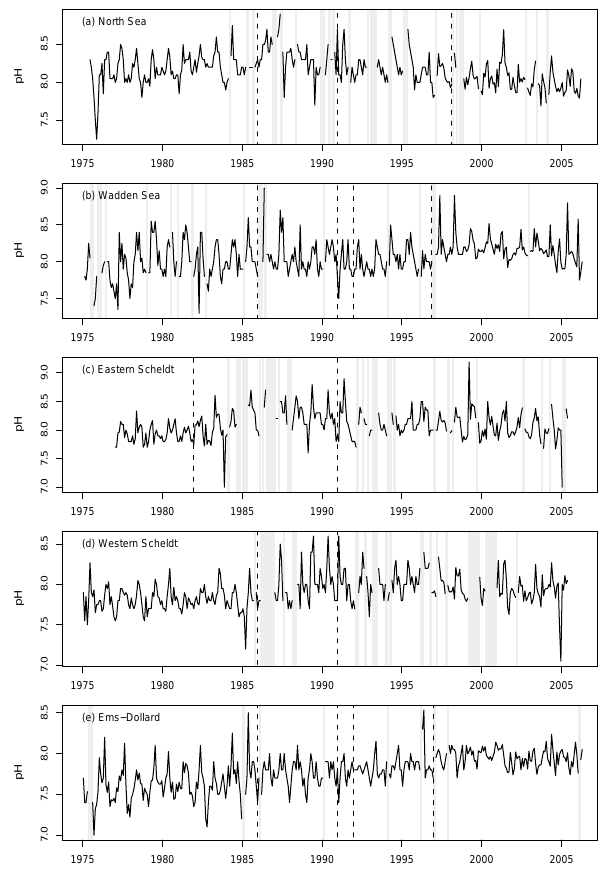
Fig. 2. Raw data from the selected stations. Dotted lines indicate a change of equipment, gray areas show where monthly data is miss- ing. See Fig. 1 for station locations.